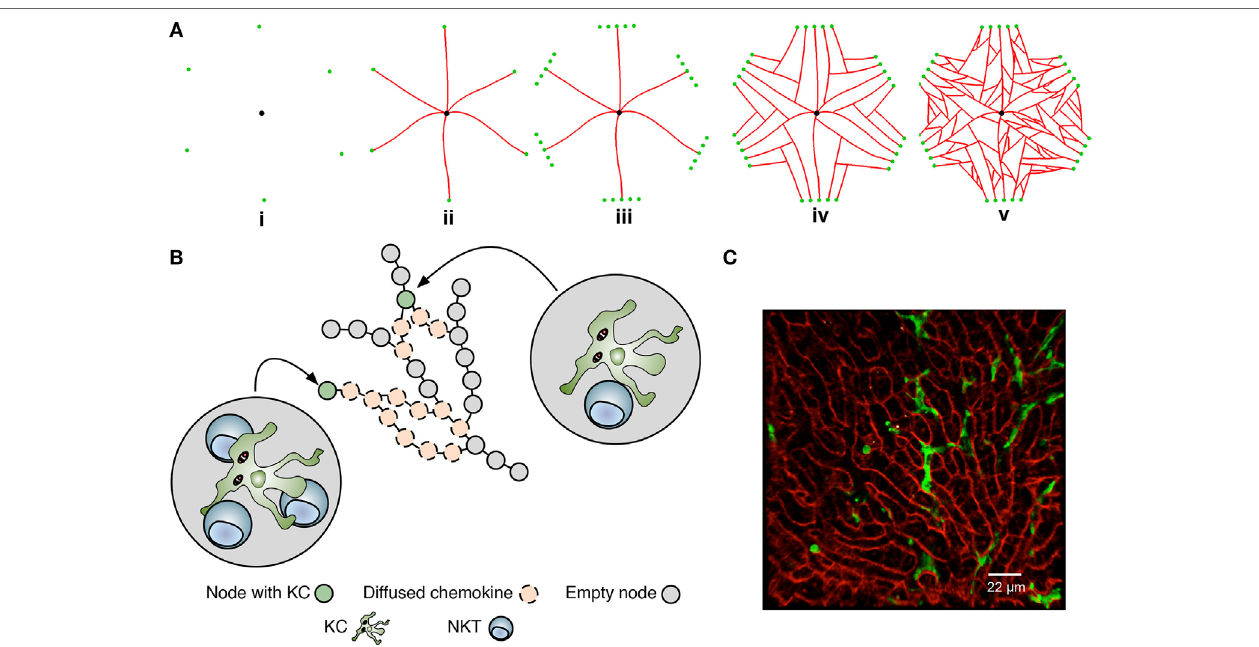
FigUre 2 | Overview of the liver agent-based model. (a) A simulated sinusoidal network was constructed in quasi-2D space using a sinusoidal structure generation algorithm (see Supplemental Experimental Procedures). A drain node representing the portal vein (black) is placed in the center of a 2D space with six surrounding entry nodes representing the portal triads (green), forming an irregular hexagon layout (i). Sinusoids (red) are grown from entry nodes to the drain node (ii). Additional entry nodes created around original entry nodes conceptual form a portal triad (iii), allow additional sinusoids to be grown (iv). Additional sinusoid branches are added between existing sinusoids (v). Execution of the algorithm is shown in Movie S1 in Supplementary Material. (B) Node structure of the model underlying KC placement and chemokine diffusion. Nodes are populated or not with a single KC and may attract natural killer T cells to that node. Chemokines exert their effect by “diffusing” across nodes. For further details, see text and Supplementary Experimental Procedures. (c) Snapshot of 2-photon image of liver from (mT/ mG × lysMcre) F1 mice, showing sinusoids (red) and KCs